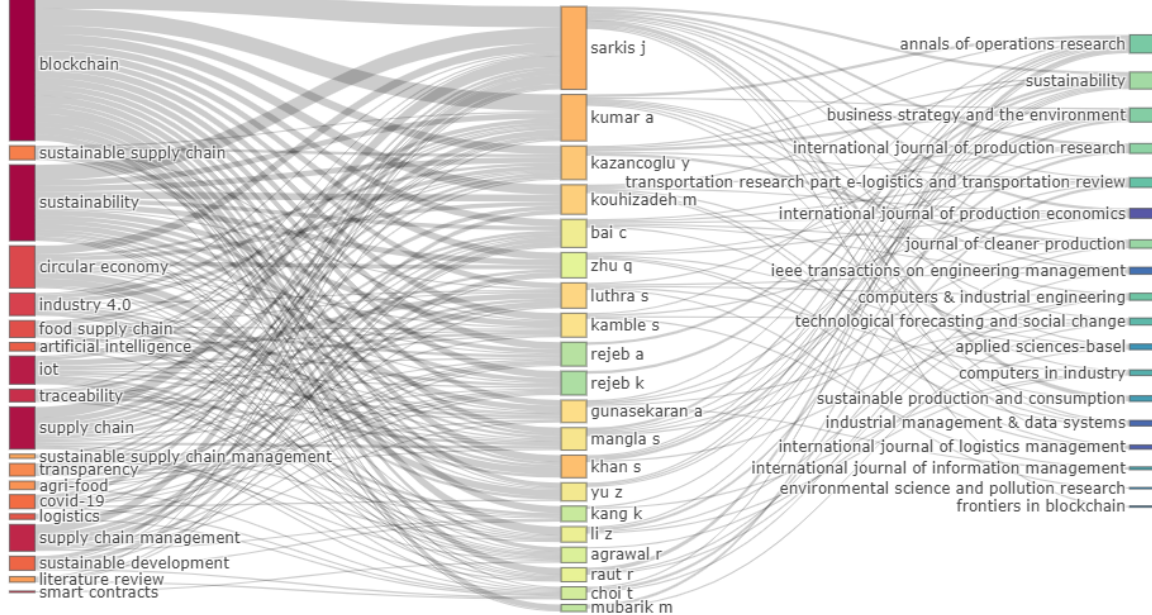
Figure 1. Three Field Plot for author’s keywords, authors, and sources.